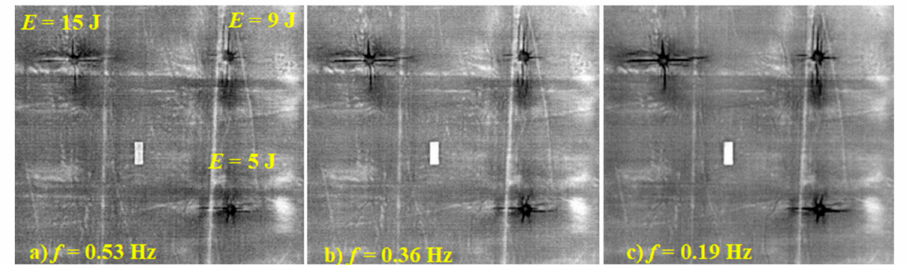
Figure 8. Phase images taken on the impacted side of the PC2B specimen at three heating frequencies; ( a ) f = 0.53 Hz; ( b ) f = 0.36 Hz; ( c ) f = 0.19